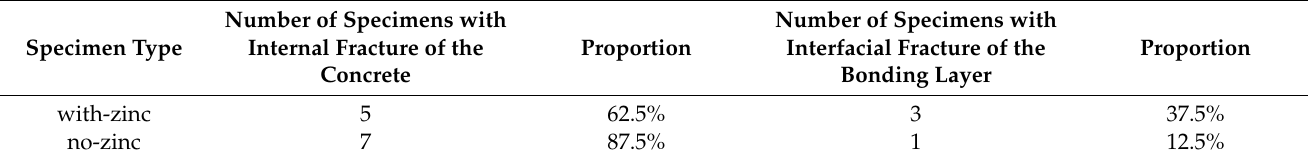
Figure 11. Influences of temperature and zinc primer on the interlayer bond strength. Table 10. Statistics of the failure modes of the with-zinc and no-zinc specimens 1 (at 60 ◦ C).